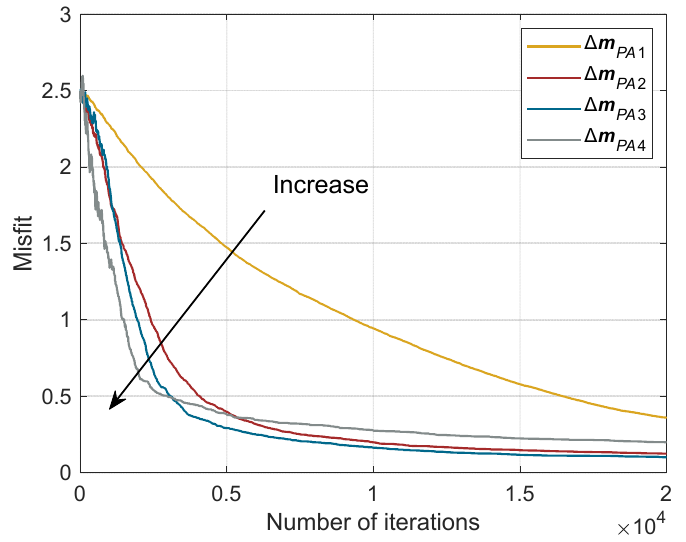
Figure 7. Misfits varying with iteration number by using the different perturbation ranges. The arrow Figure 7. Mis fi ts varying with iteration number by using the di ff erent perturbation ranges. The ar- indicates the direction of range increase. The definitions of curves are given in the row indicates the direction of range increase. The de fi nitions of curves are given in the legend.